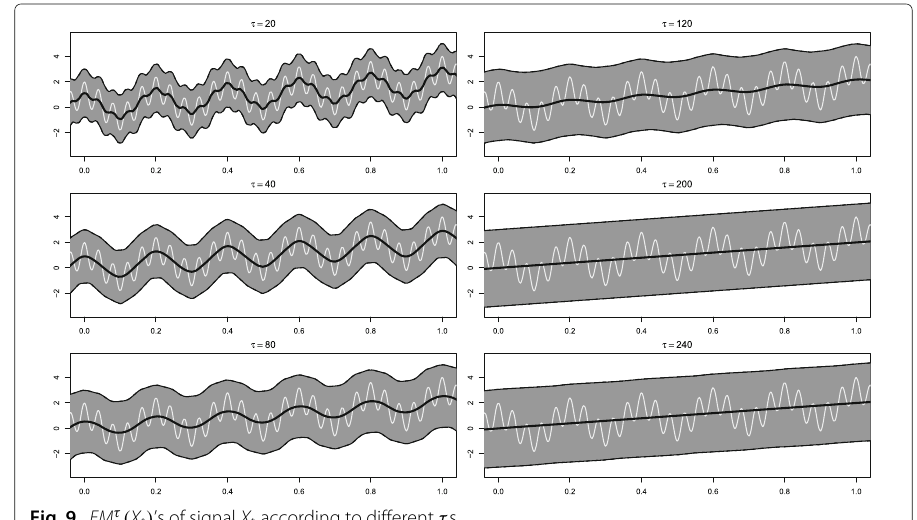
Fig. 9 EM τ t ( X t ) ’s of signal X t according to different τ s